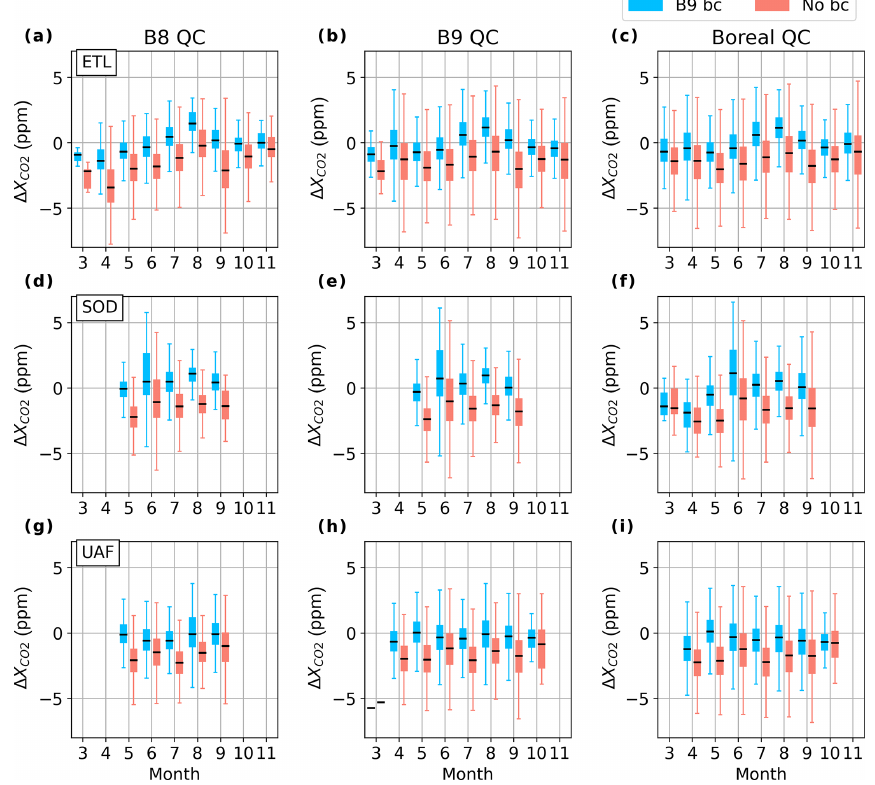
Figure 11. Box plots of distributions of monthly biases for each boreal forest site and for each QC, showing results with and without the standard B9 bias correction (bc). Box plots show the median in the center of the box, the first and third quartile as the bottom and top of the box, and the full range of data values as the bars extending above and below the box. Note that bias is defined as ( (cid:49)X CO retrieval) i − ( ˜ X NNG ) i ) for each coincident OCO-2 sounding.